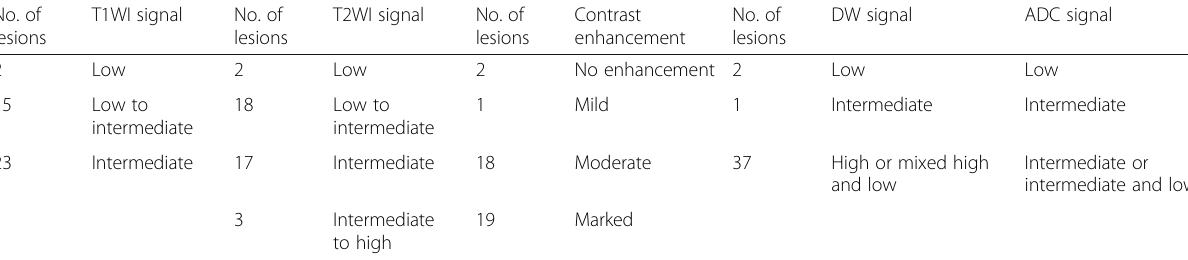
Table 2 Signal characteristics of DF lesions on different conventional and diffusion-weighted images No. of lesions